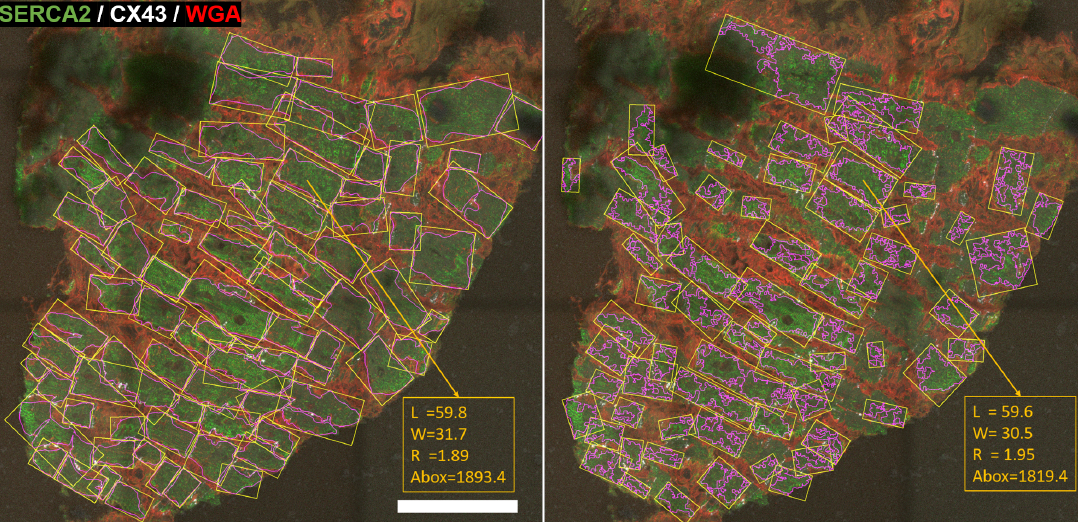
Figure 8. CMs in the manual ( left ) and automatic ( right ) masks contoured in pink, with enclosing rectangles in yellow. At the bottom right corner of each panel is an example of morphological measures computed for a CM detected in both masks. Scale bar = 100 µ